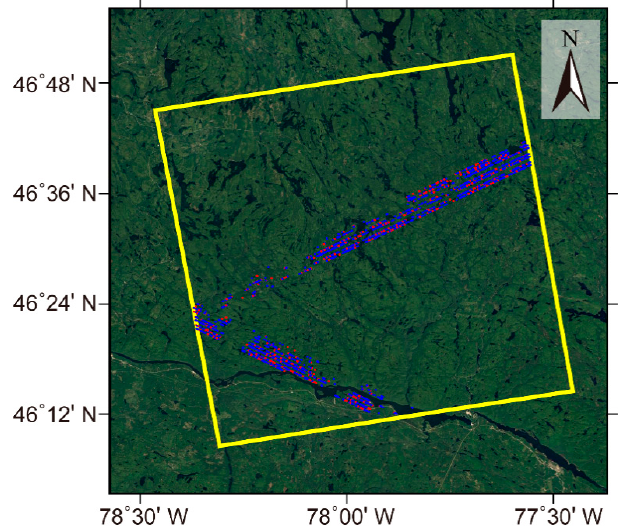
Figure 8. The coverage of the ALOS-2 PARSAR-2 Interferometric pair (yellow rectangle) and the spatial distribution of the GEDI observations (the blue and red points represent the training sample and validation data, respectively). The background image was downloaded from Google Earth.